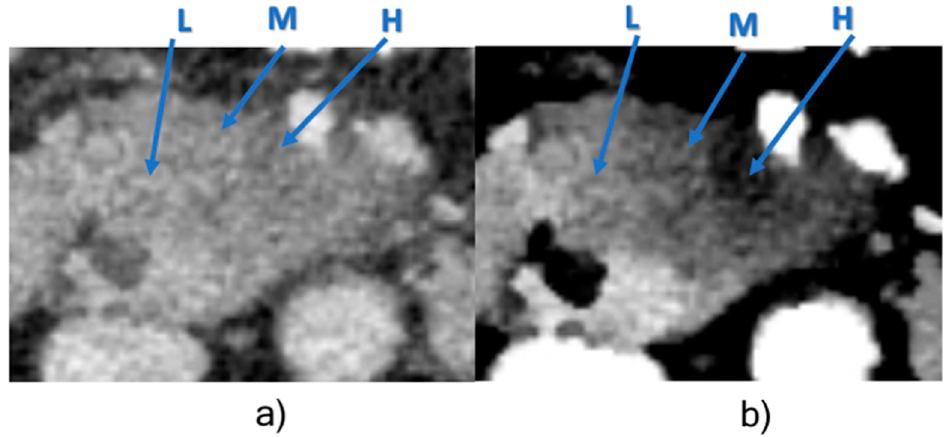
Figure 2. Low (L), intermediate (M) and high (H) cellularity levels within one tumor slice. ( a ) Conventional image. ( b ) monoE 40 keV image. Window settings (level/width): 50/350 for conventional CT, 250/350 for monoE 40 keV.